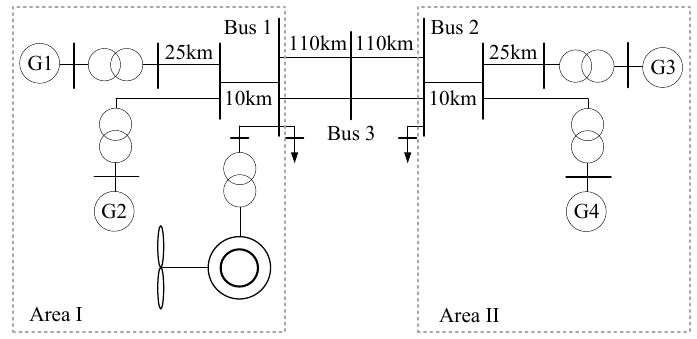
Figure 1. The structure of the study system.